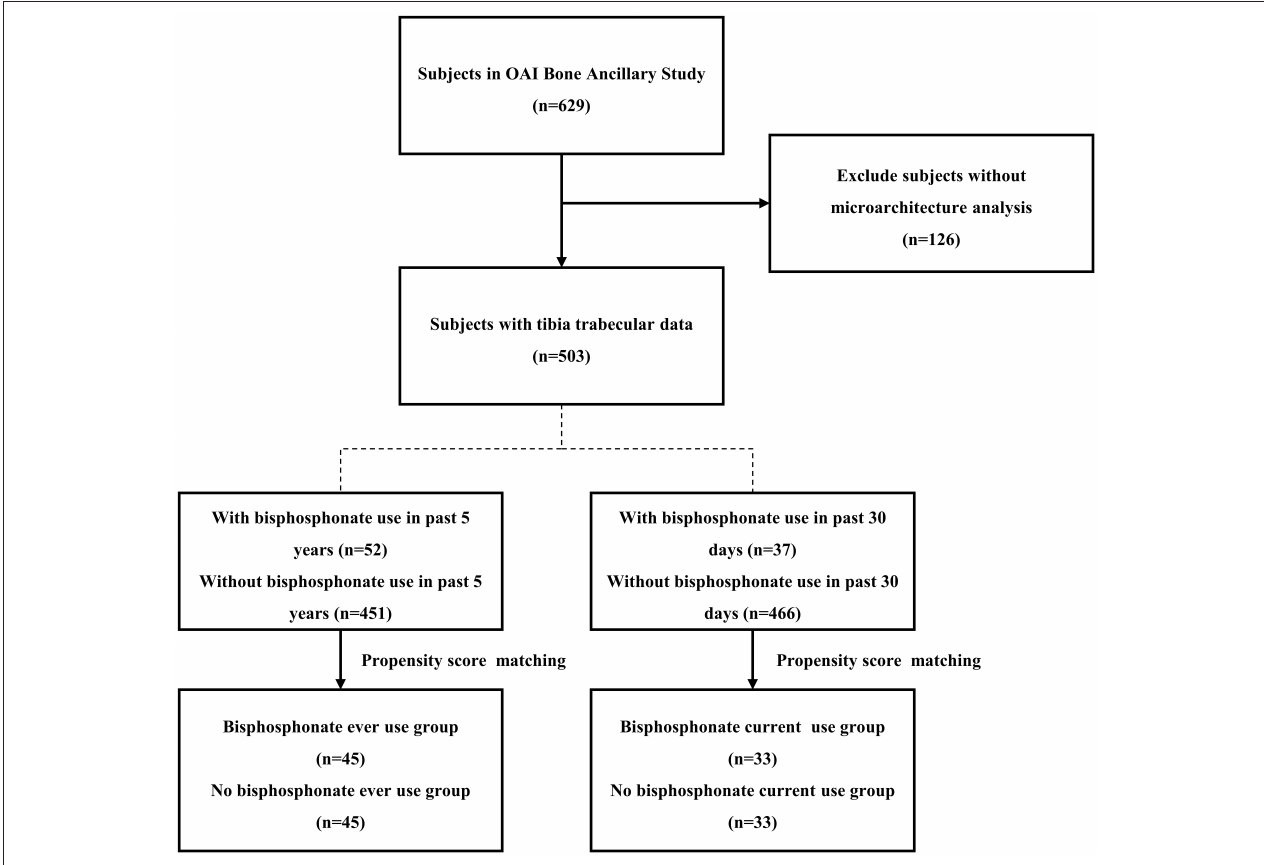
FIGURE 2 | The flowchart for screening